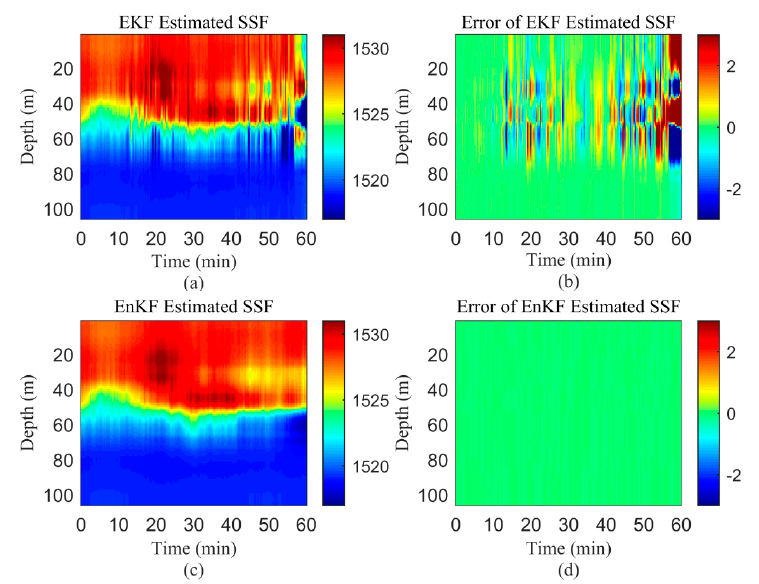
Figure 4. Inversion for the time-evolving sound speed field (SSF), the SSF is discretized in 180 intervals by the corresponding moving source. ( a , c ) represent the EKF and EnKF estimation results; and ( b , d ) are the error of the filters respectively.